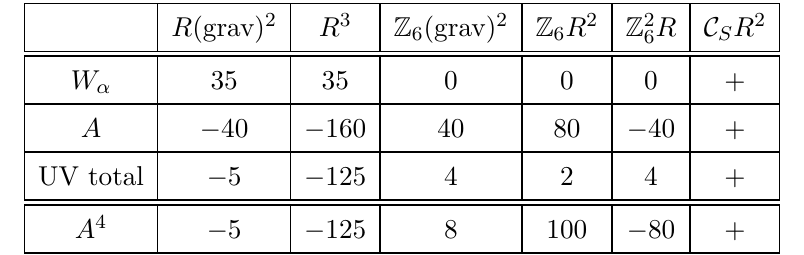
anomalies are not 6